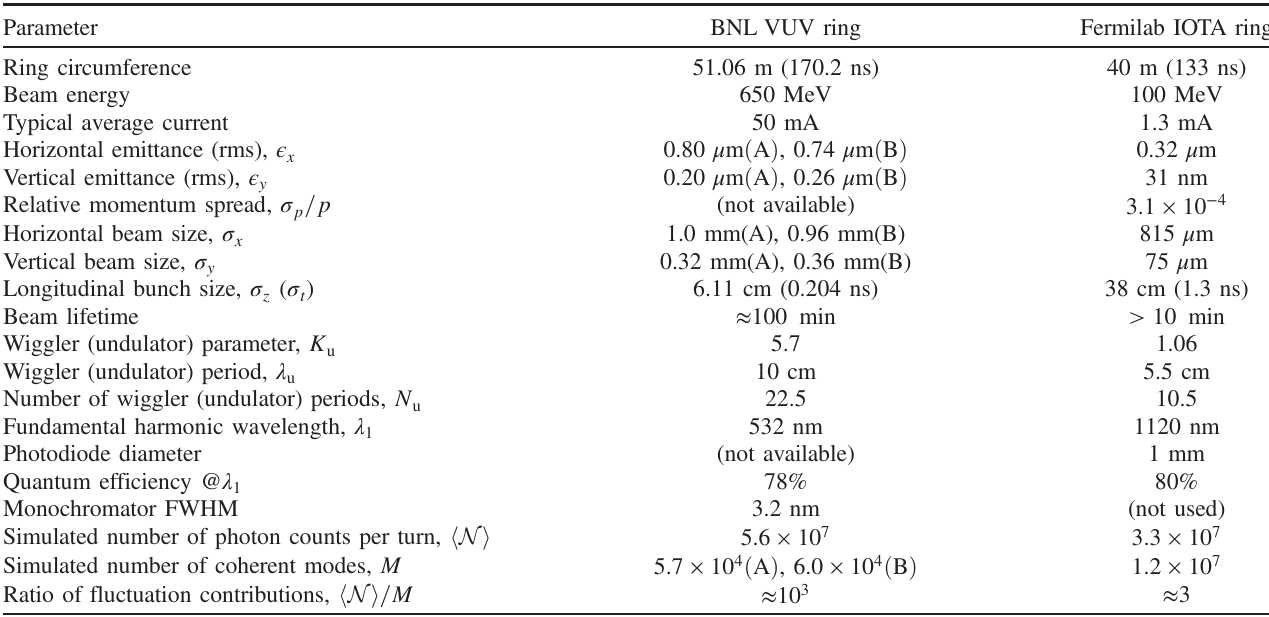
TABLE I. Summary of the parameters of the Brookhaven experiment [1] and the proposed experiment at Fermilab in the IOTA storage ring [16,18]. The electron bunch dimensions correspond to the center of the wiggler (undulator). Both rings store a single electron ¼ 1 . 3 mA. For more details about the undulator in IOTA, see [37]. Some parameters bunch. The parameters of IOTA are given at I beam of the BNL VUV ring are followed by (A) or (B) to specify the corresponding lattice